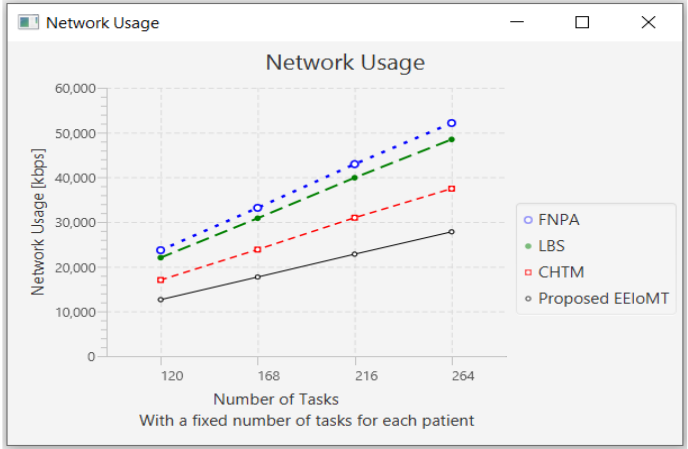
Figure 22. Network usage comparison when changing the number of tasks.